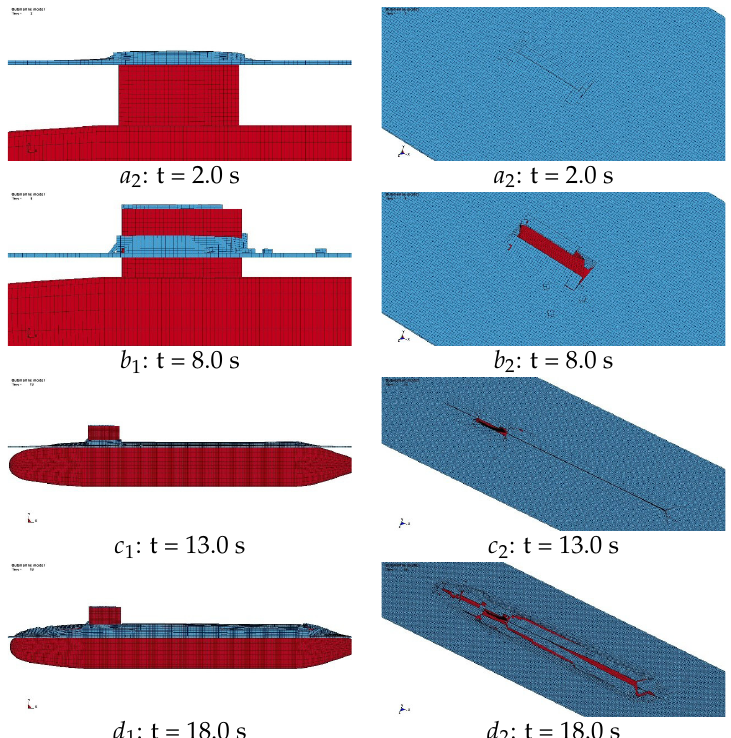
Figure 5. Numerical simulation of the process of submarine ice breaking.